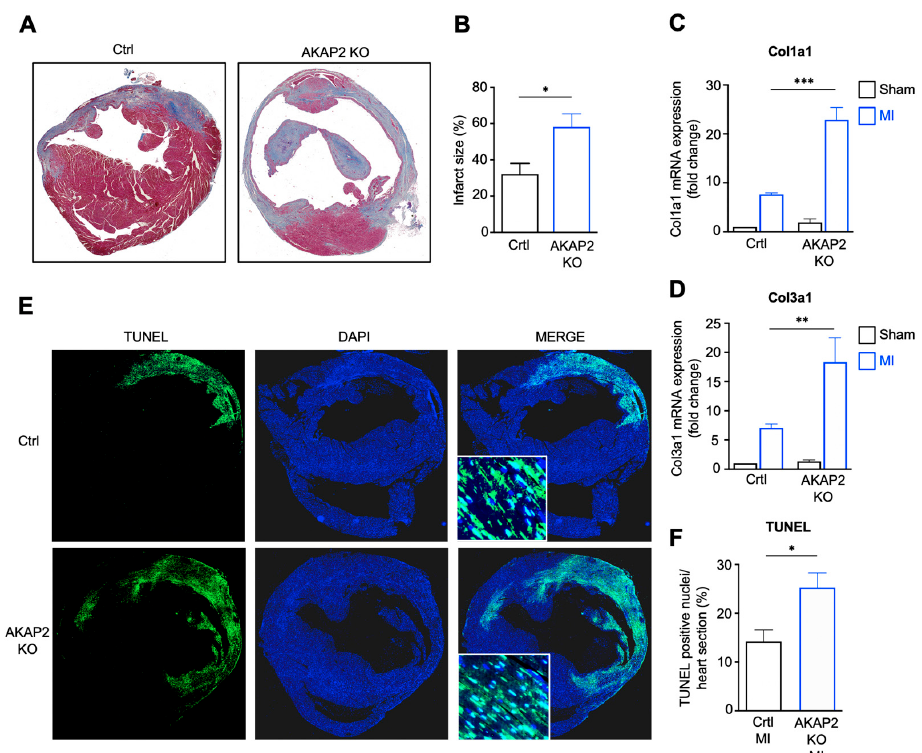
Figure 3. AKAP2 knockout in adult cardiomyocytes enhances myocardial apoptosis, fibrosis and infarct size after LAD ligation. ( A ) Masson’s Trichrome stainings performed on mid-ventricular heart sections from control (Ctrl) and cardiomyocyte-specific AKAP2 KO male mice 2 weeks after MI. ( B ) Quantitative assessment of infarct size. For each heart, the proportion of scar tissue in the left ventricle was quantified on 3 or 4 mid-ventricular transversal sections stained with Masson’s Trichrome. Ctrl-MI n = 7; AKAP2 KO-MI n = 4. ( C , D ) The relative mRNA expression of